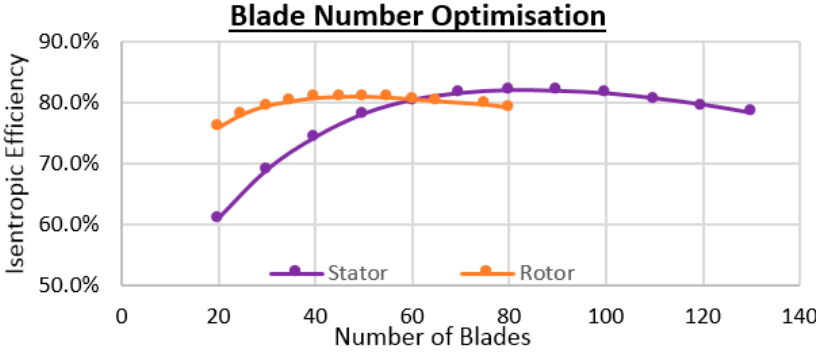
Figure 18. Data regarding the optimisation of the allocated blade numbering.